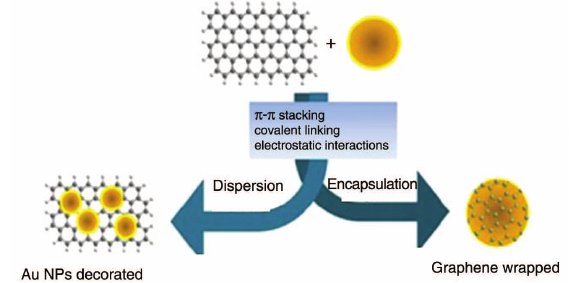
Figure 5: The decoration of GO and rGO with gold nanostructures using different interaction forces. Adapted from Ref. [14] with the permission of The Royal Society of